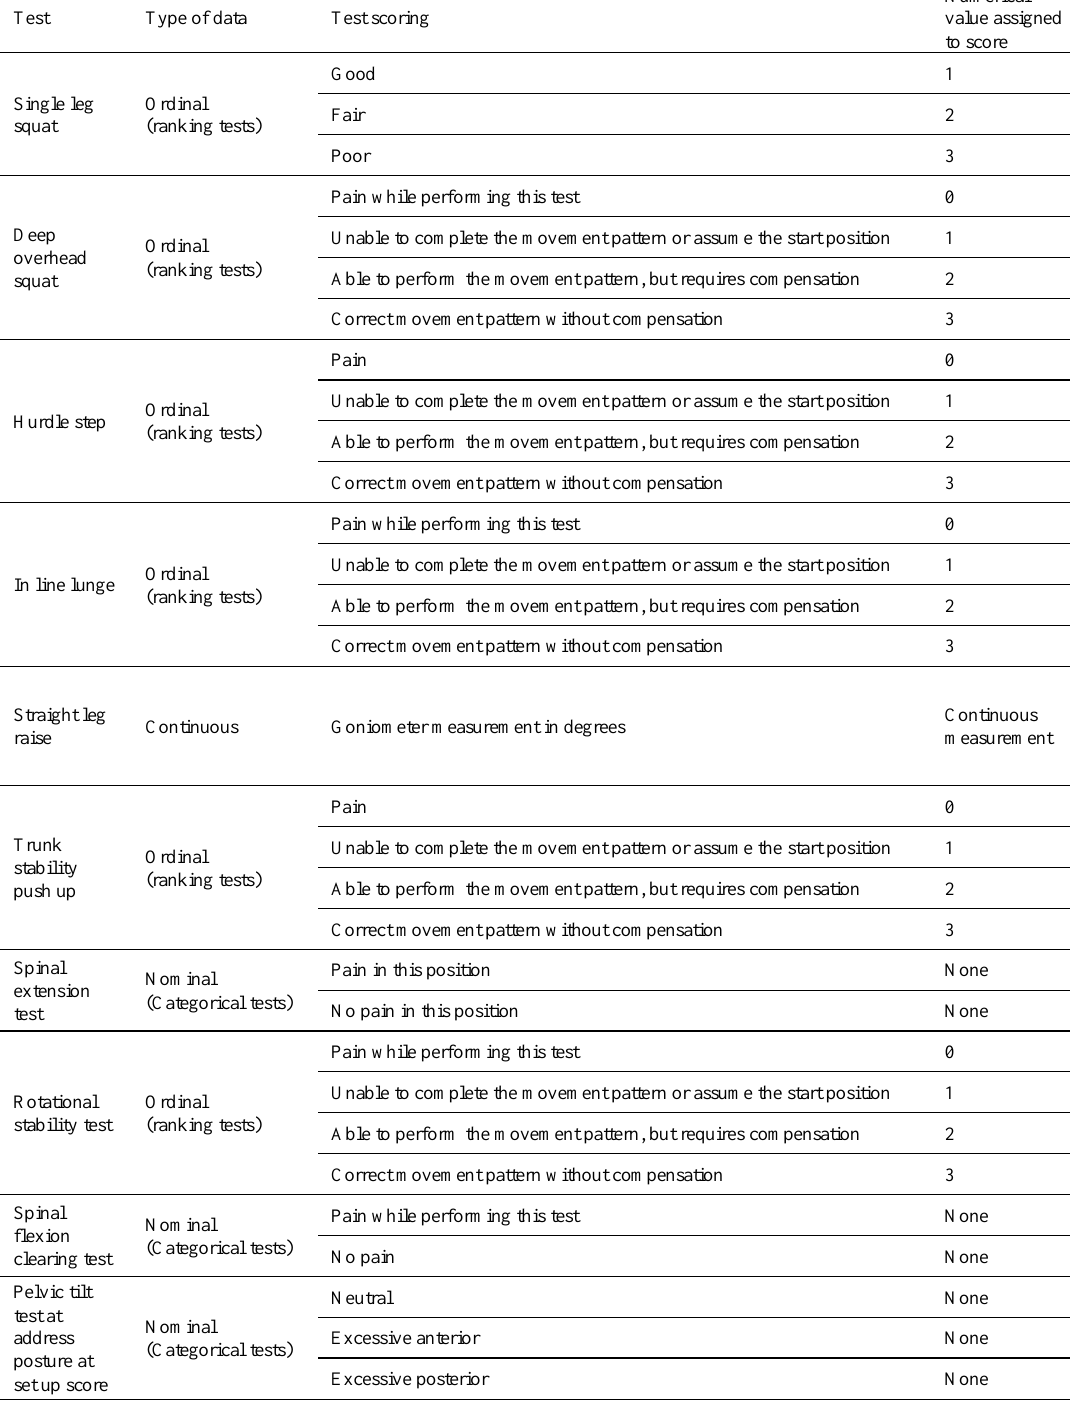
Page 1 of 3: Table of functional tests scoring and the type of data each that each functional movement test